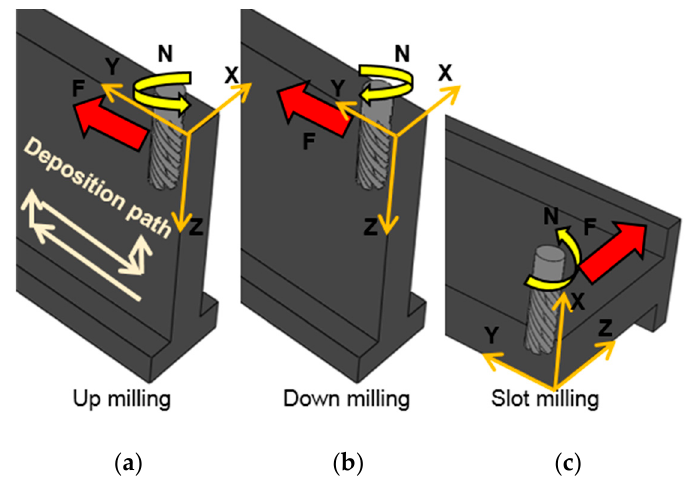
( b ) Figure 3. Walls preparation by Plasma Arc Welding (PAW)-Wire Arc Additive Manufacturing (WAAM) technologies: ( a ) wrought wall ( b ) machined wall . Figure 3a shows the poor surface finish and dimensional accuracy on the wrought wall after the PAW-WAAM process. In order to study the effect of the workpiece material on the process (AM versus conventional titanium alloy), a uniform radial depth of cut should be obtained during the milling operation. To do so, the workpiece manufactured by AM was pre-machined. Figure 3b illustrates the machined wall after its preparation. This previous machining operation is also mandatory for the study of the material properties. Before explaining the tests to be performed, Figure 4 shows the three milling strategies studied